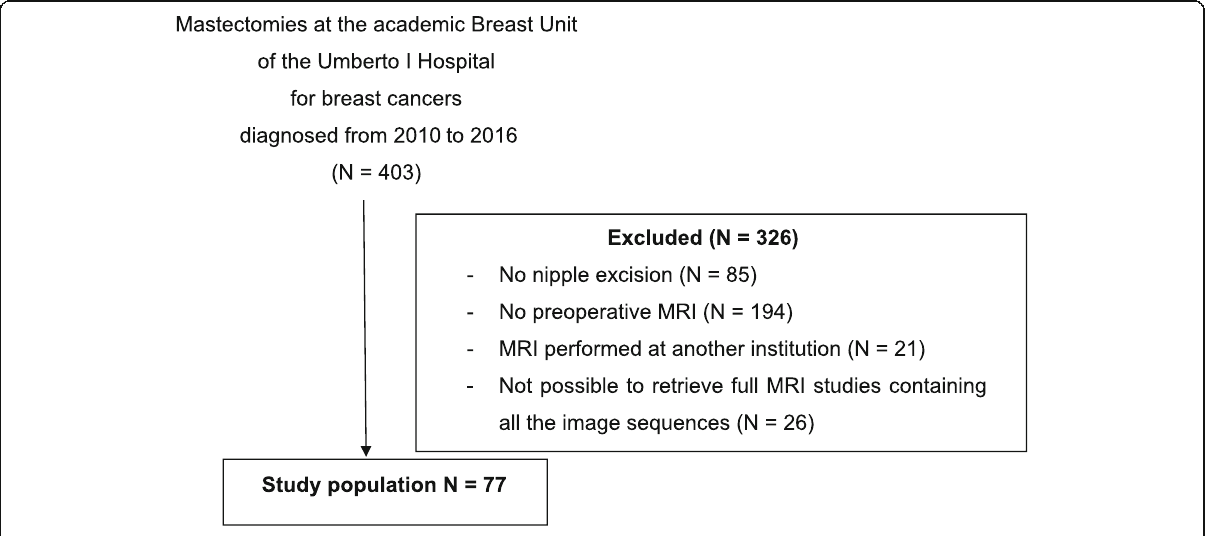
Fig. 1 Patient selection diagram. N number, MRI magnetic resonance